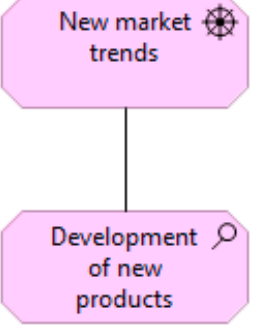
Figure 3. Analysis of external factors and society.